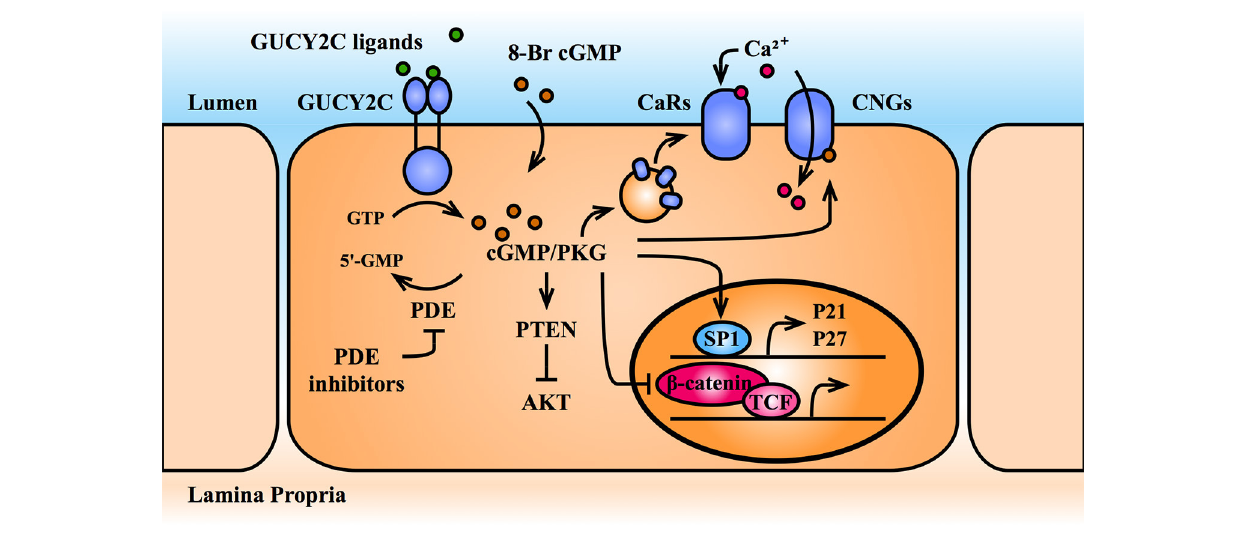
FIGURE 4 | cGMP opposes cellular proliferation. cGMP elevating agents include GUCY2C agonists, PDE inhibitors, and cell-permeable 8-Br-cGMP. cGMP and its effector, PKG, oppose intestinal epithelial cell proliferation by upregulating nuclear transcription of cell cycle inhibitors (p21 and p27) and by opposing pro-proliferative transcription mediated by the β -catenin/TCF and Akt pathways. Further, cGMP recruits calcium-sensing G-protein coupled receptors (CaRs) to the plasma membrane and directly activates cGMP-gated calcium channels (CNGs), promoting Ca 2 + -mediated cytostasis. Akt, protein kinase B; CaR, calcium-sensing receptor; cGMP, cyclic guanosine monophosphate; CNG, cGMP-gated calcium channel; GTP, guanosine triphosphate; GUCY2C, guanylate cyclase C; p21, cyclin dependent kinase inhibitor 1A; p27, cyclin-dependent kinase inhibitor 1B; PDE, phosphodiesterase; PKG, protein kinase G; PTEN, phosphatase, and tensin homolog; SP1, specificity protein 1; TCF, T-cell factor; 5 ′ -GMP, 5 ′ -guanosine monophosphate; 8-Br-cGMP,